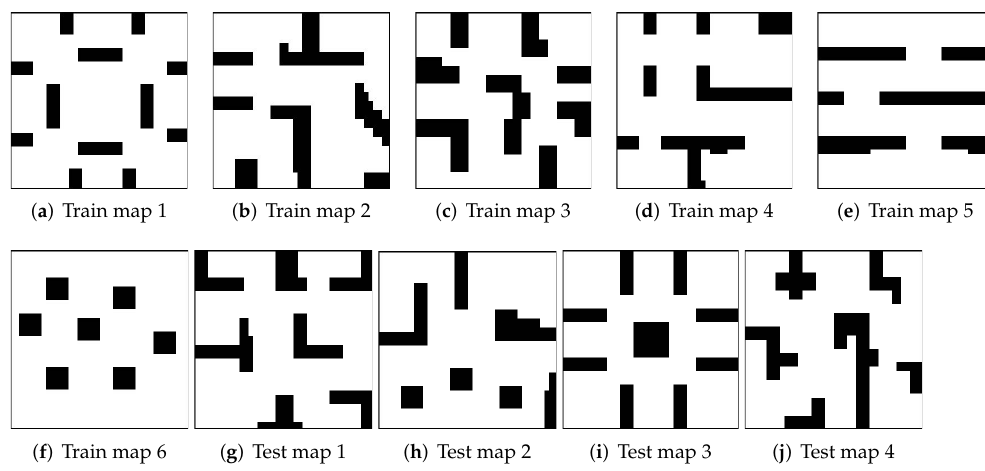
Figure 8. The different 2D grid maps without moving